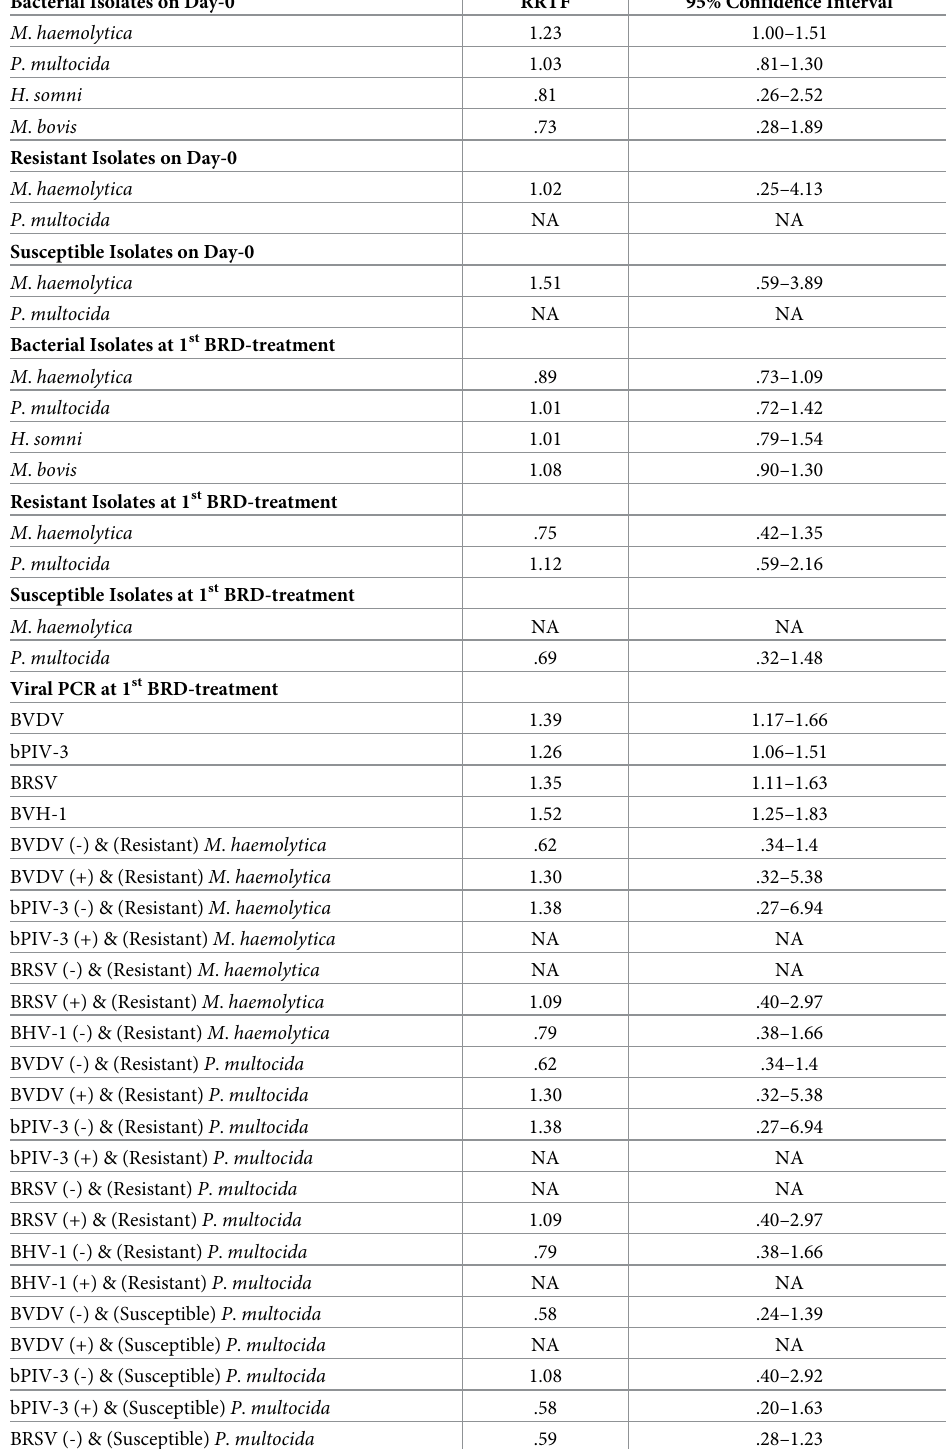
Table 10. Relative risk of treatment failure for BRD diagnostic test methods from upper respiratory tract samples in high-risk feeder